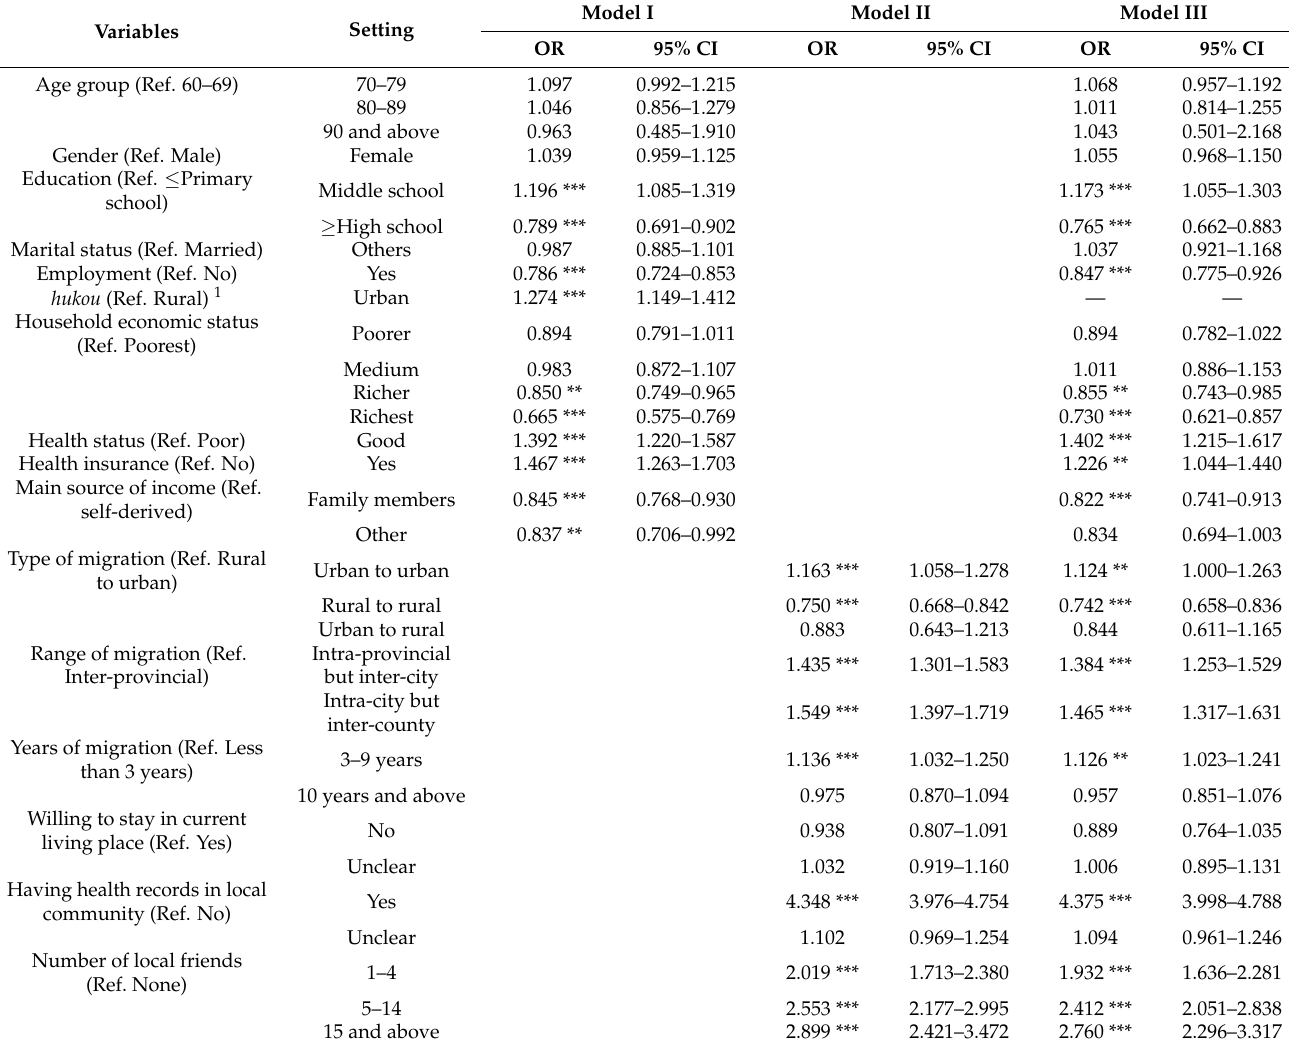
Table 4. Factors affecting annual physical examination among unmatched older migrants in China ( n =